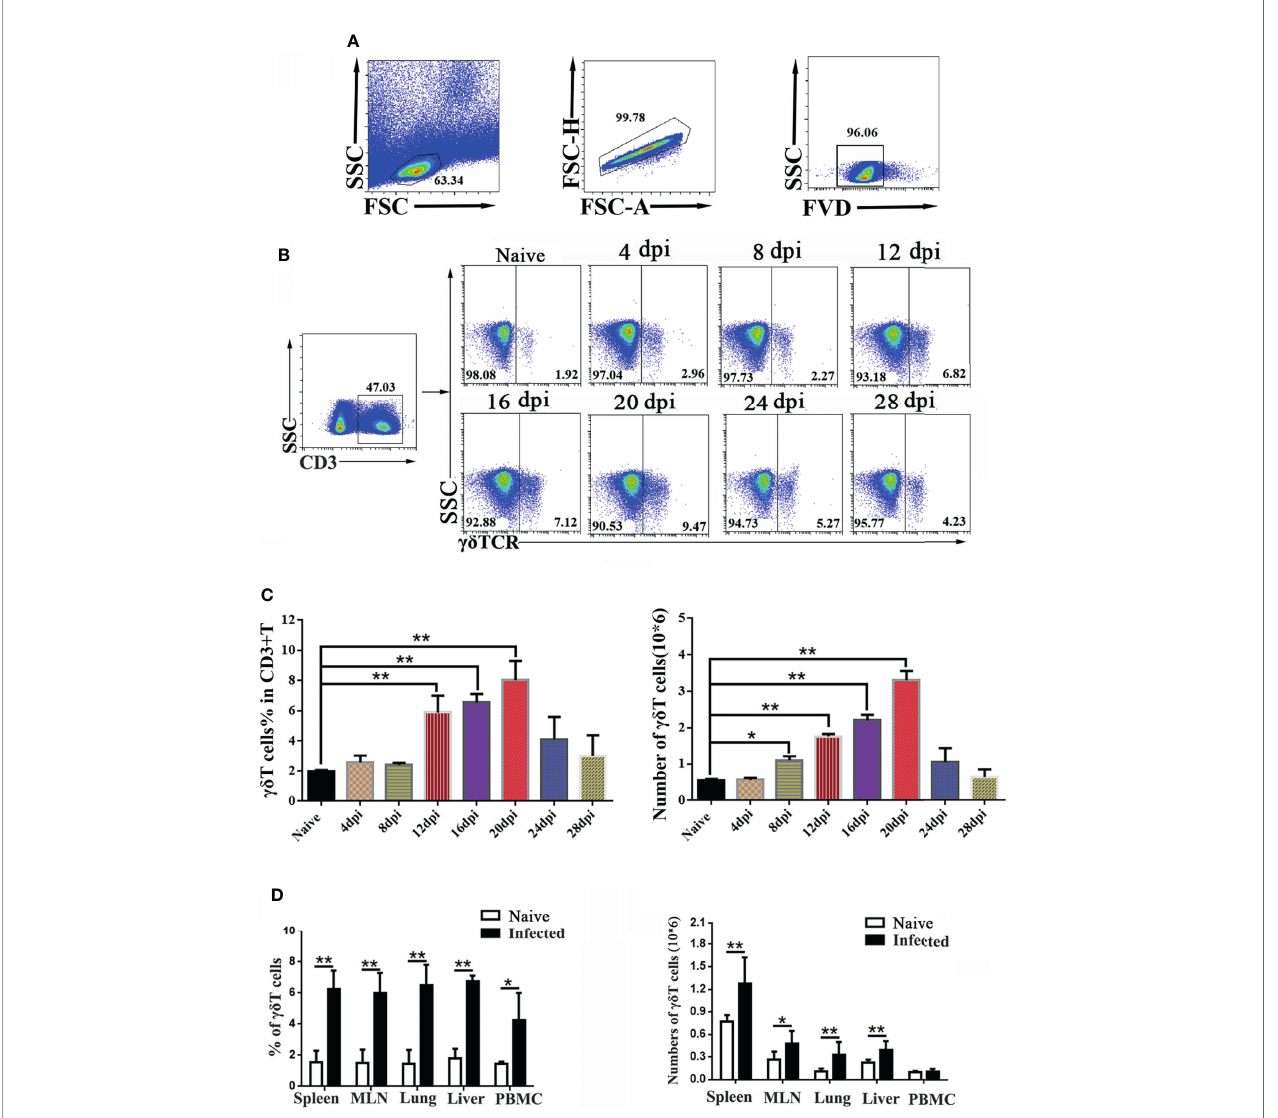
FIGURE 1 | Dynamic changes in gd T cells in the spleen of P. yoelii NSM infected mice. Fourteen days after Plasmodium infection, lymphocytes from the spleen, MLN, lung, liver, and PBMC of C57BL/6 mice were isolated. Different fl uorescence-labelled mAbs against mouse CD3 and gd TCR were used to detect the content of gd T cells by fl ow cytometry. (A) All the doublet cells, dead cells, and nonlymphoid cells were excluded from fl ow cytometry data. (B, C) Dynamic changes in gd T cells in the spleens of C57BL/6 mice infected with Plasmodium were determined by FCM from day 4 to day 28, simultaneously setting up naive control. (D) Averages of gd T cells in infected mice in different organs were calculated after FCM analysis. Cell numbers of gd T cells from different organs in infected mice, compared with naive groups. Representative results of three independent results are shown. The average of three independent experiments with 3-5 mice per group was shown and repeated three times with similar results. The error bars are SD, * P < 0.05, ** P <